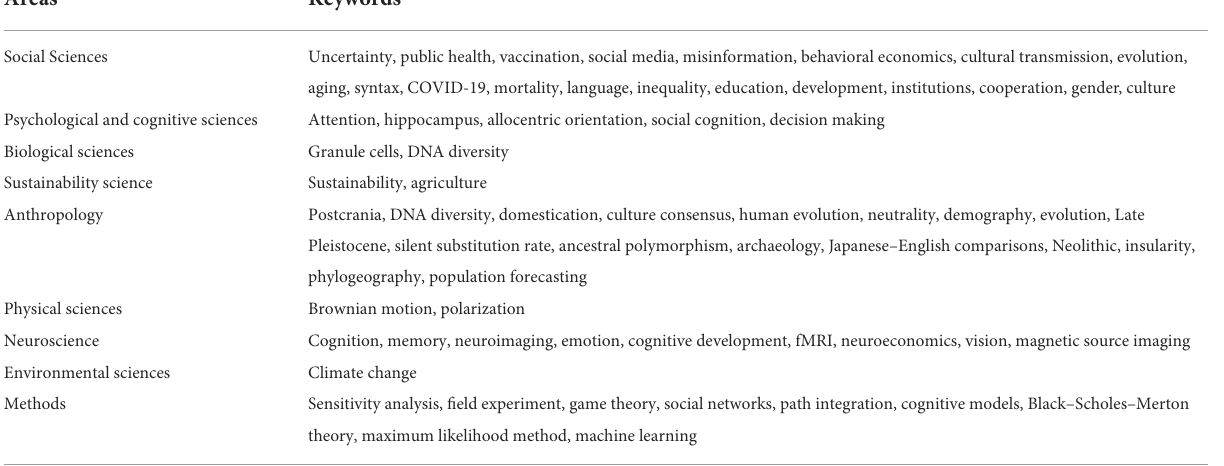
TABLE 7 List of nine subject areas and the corresponding elite keywords.